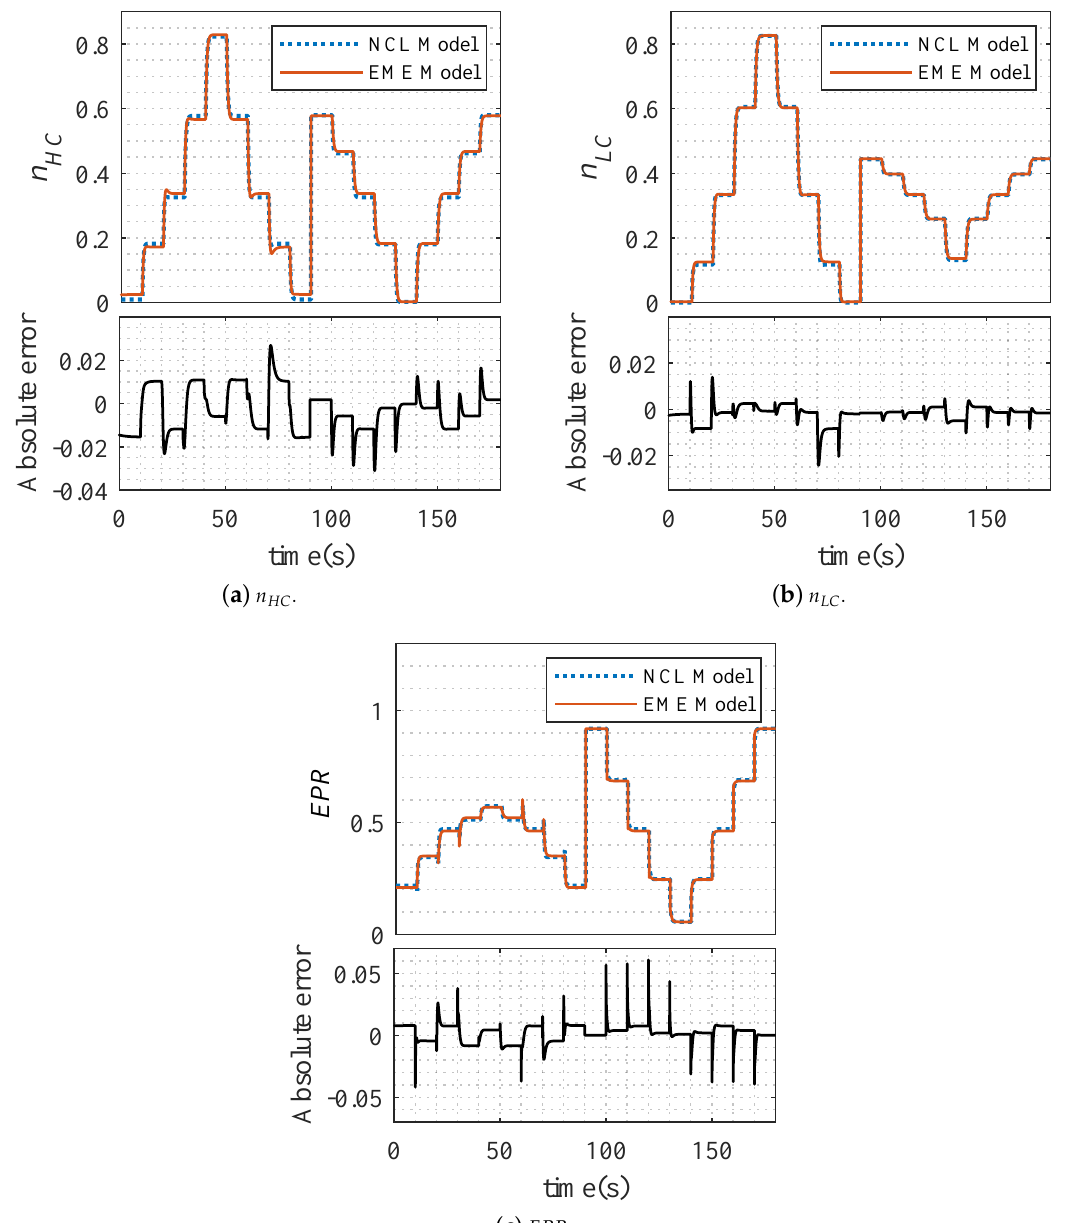
Figure 9. The identification result and absolute error of the EME ( α = [ n HC , A n ] )